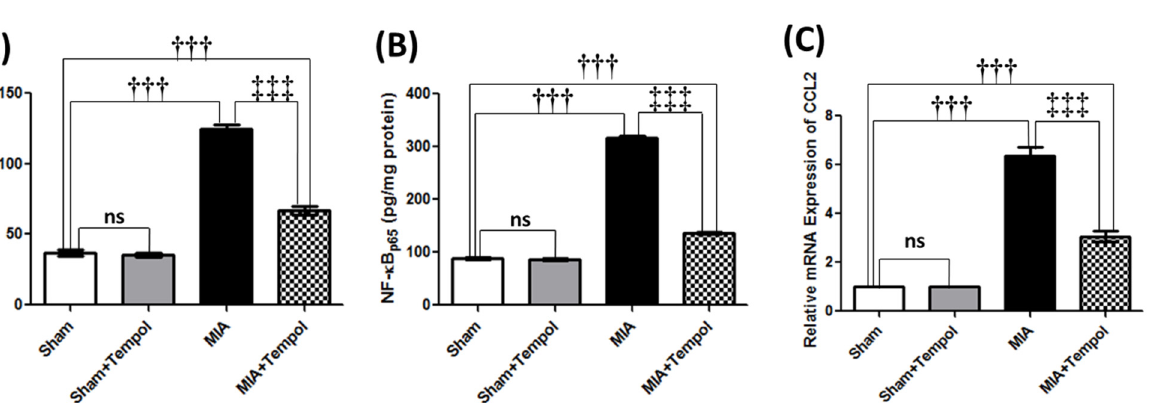
Figure 7. Effect of Tempol on representative X-ray radiographs. Normal radiographs were revealed in the sham group ( A ) and Sham+Tempol group ( B ) along the hip-knee-ankle (HKA) axis. However, the images of the MIA-induced OA group ( C ) showed increased joint opacity, and osteophyte formation (white arrow) associated with rough surfaces of the femoral